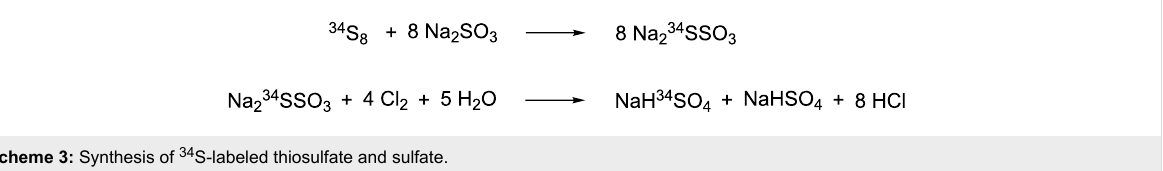
Scheme 3: Synthesis of 34 S-labeled thiosulfate and sulfate.